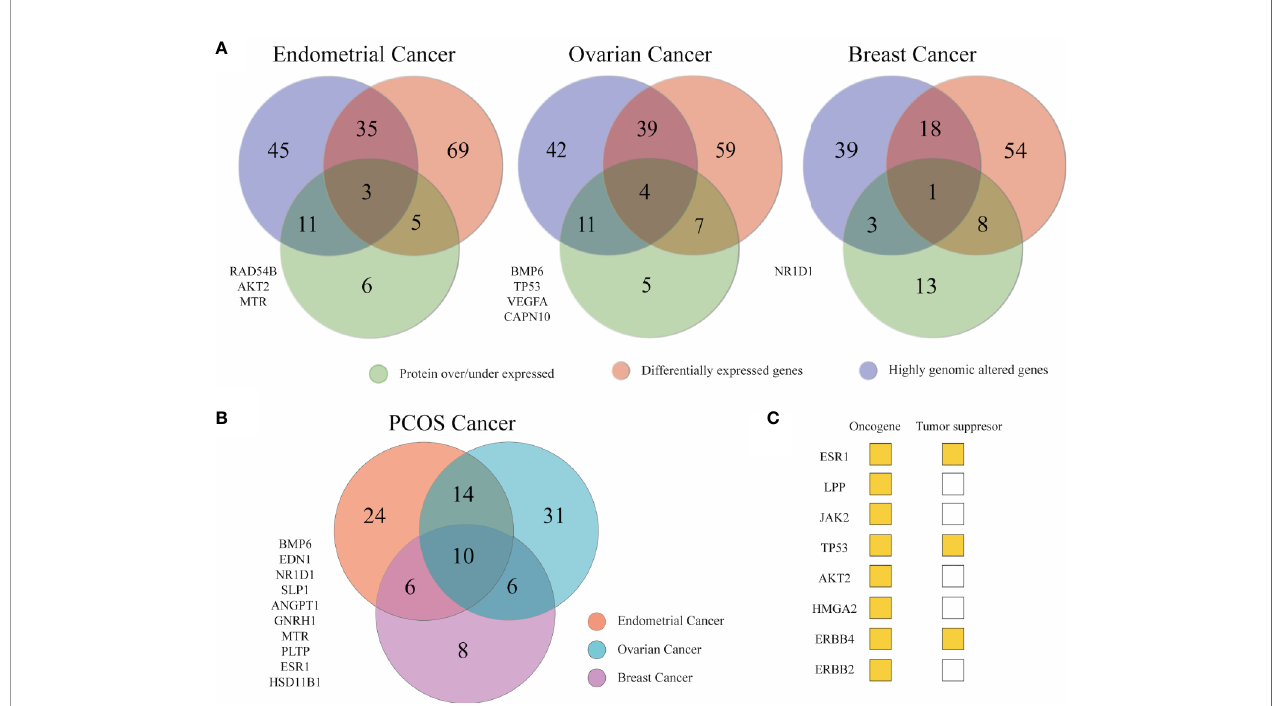
FIGURE 6 | Key genes between gynecological cancer and PCOS. (A) Venn diagrams depicting the number of unique and shared associated PCOS across the three omics approaches. The list of genes at the left are the genes that appeared in the three omics approaches in each cancer type. (B) The Venn diagram shows PCOS related genes altered in at least two omics approaches in breast and gynecological cancers to stablish a relationship between the syndrome and cancer